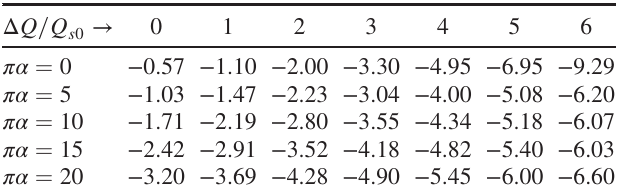
TABLE II. The TMCI threshold of the exponential wake due to a coalescence of the lowest multipoles m ¼ 0 and m ¼ − 1 at modest space charge tine